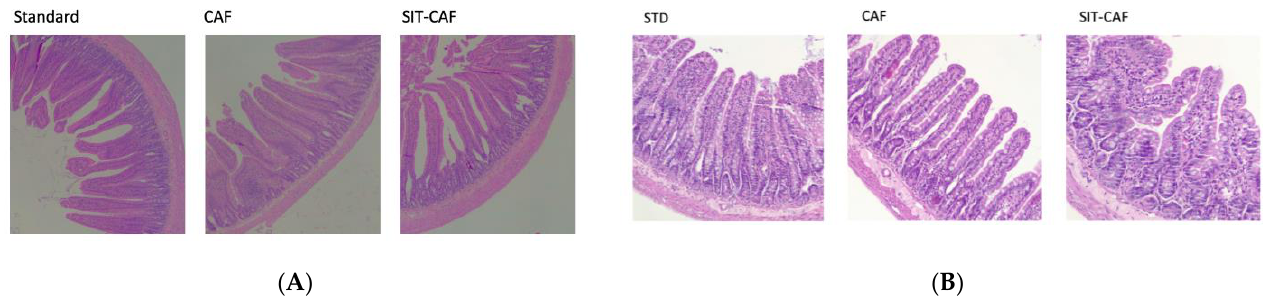
Figure 3. ( A ) Haematoxylin and eosin (H&E) staining of duodenum samples of STD, CAF, and SIT-CAF groups. CAF, rats fed a cafeteria diet; STD, rats fed a standard chow diet; ( B ) Haematoxylin